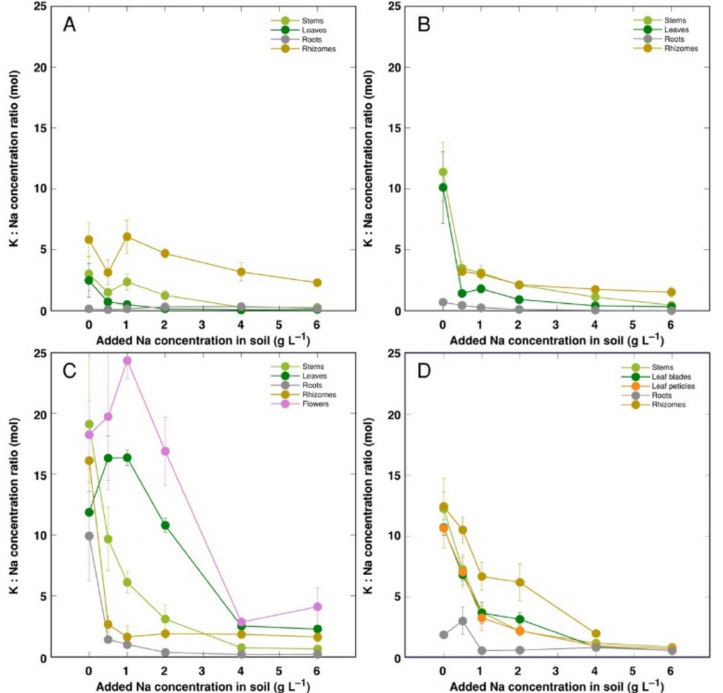
Figure 7. Changes in Na + : K + concentration ratio under the effect of increasing soil salinity in different parts of Calystegia sepium accessions CSe1 ( A ), CSe2 ( B ), CSe3 ( C ) and Calystegia soldanella ( D ). Na + was added in a form of NaCl. Data are means from three replicates for each concentration ± SE. Asterisks of the respective color indicate statistically significant differences ( p < 0.05) from